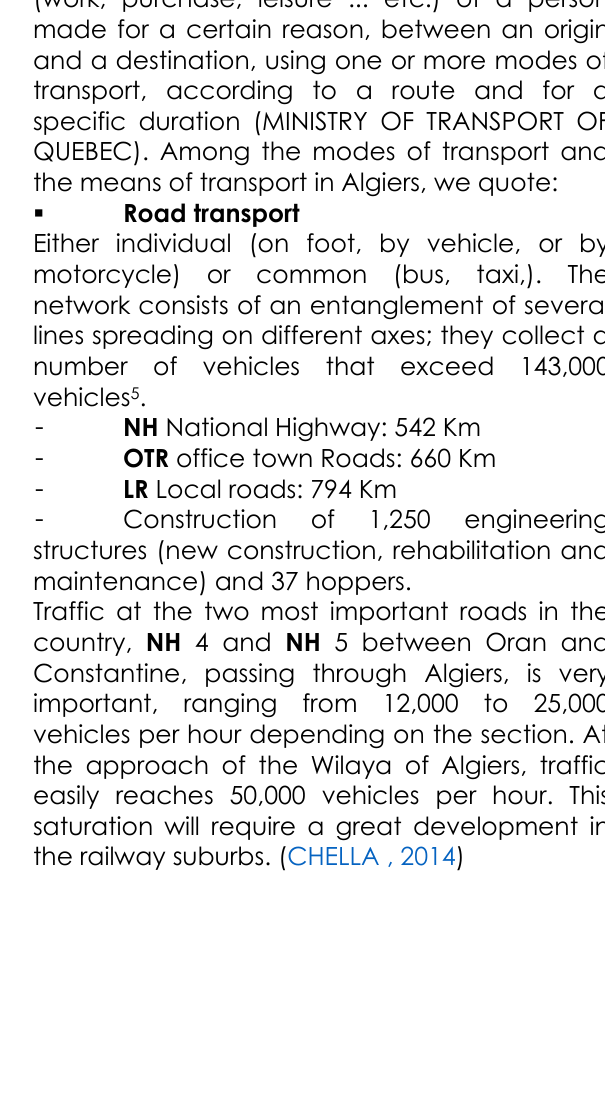
Figure 1. Situation of Wilaya of ALGIERS (treatment Source: Google